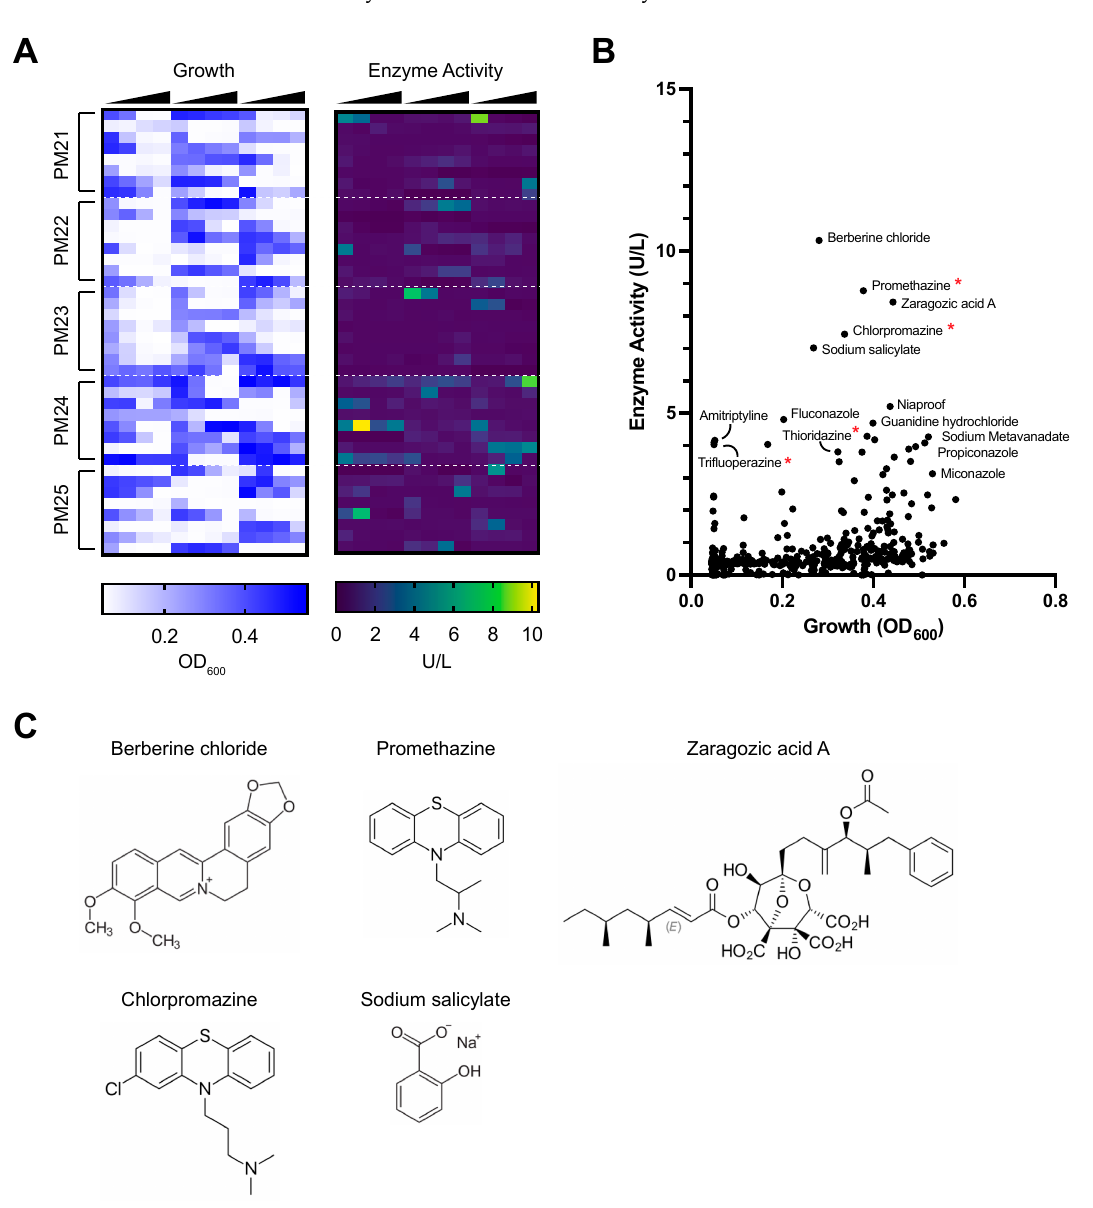
Figure 1. Chemical screen to identify inducers of laccase activity in P. radiata . ( A ) Heatmaps depicting growth of P. radiata using OD 600 measurements (left) and extracellular enzyme activity using ABTS oxidation assays (right) in response to fungal chemical stressors in Biolog Phenotype Microarray (PM) plates. The heatmap orientation represents the 96-well plate layouts of the PM plates tested. Each chemical was tested across a range of four concentrations, grouped from low to high, and the concentration range is depicted by black triangles above the heatmap plots. Chemical names and their locations in the heatmaps can be found in Supplementary Table S1. Values depicted represent the average of n = 2 biological replicates. ( B ) Scatter plot depicting P. radiata growth vs. enzyme activity in the phenotype microarray chemical sensitivity screen. Red asterisks highlight phenothiazine compounds. ( C ) Chemical structures of the top 5 compounds that induced the highest levels of laccase activity in P. radiata.